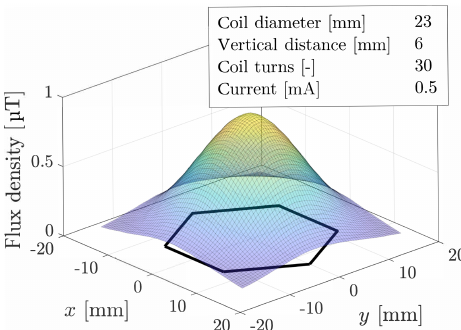
Figure 2. Bell-shaped flux density curve (magneto-static simula- tion).